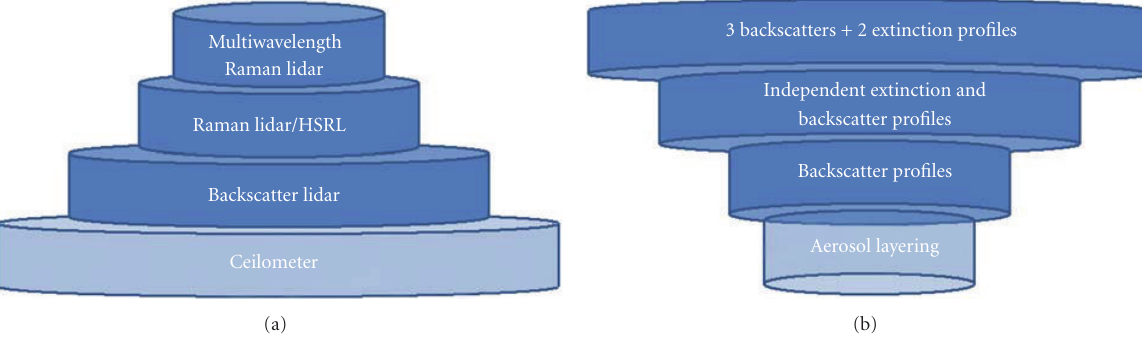
Figure 1: Aerosol lidar techniques pyramidal diagrams: complexity/distribution (a) and corresponding top level products